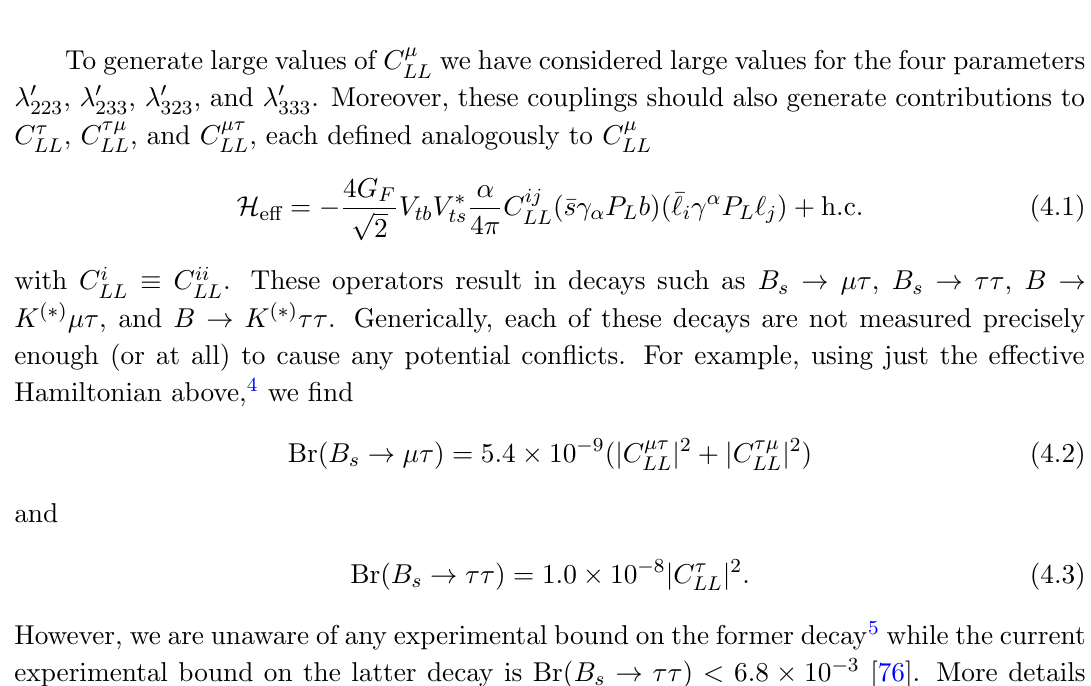
Figure 7 . Example (cid:12)gure showing solid contours of C (cid:22) for parameter space similar to that LL considered in ref. [48]. For this (cid:12)gure, we set (cid:21) 0 = 0 : 05, (cid:21) 0 = (cid:0) 0 : 5, m ~ = 300 GeV, and 323 333 W m ~ u = m ~ c = m ~ = m ~ = m ~ (cid:23) = m ~ (cid:23) = 2 TeV. Dashed contours show energy scales of Landau t L b R (cid:22) (cid:28) L L poles in TeV. Parameter space excluded by B s (cid:0) (cid:22) B s mixing is shown in blue. Parameter space excluded by B ! K ( (cid:3) ) (cid:23) (cid:22) (cid:23) is shown in orange. Finally, parameter space excluded by Z decays to charged leptons is shown in